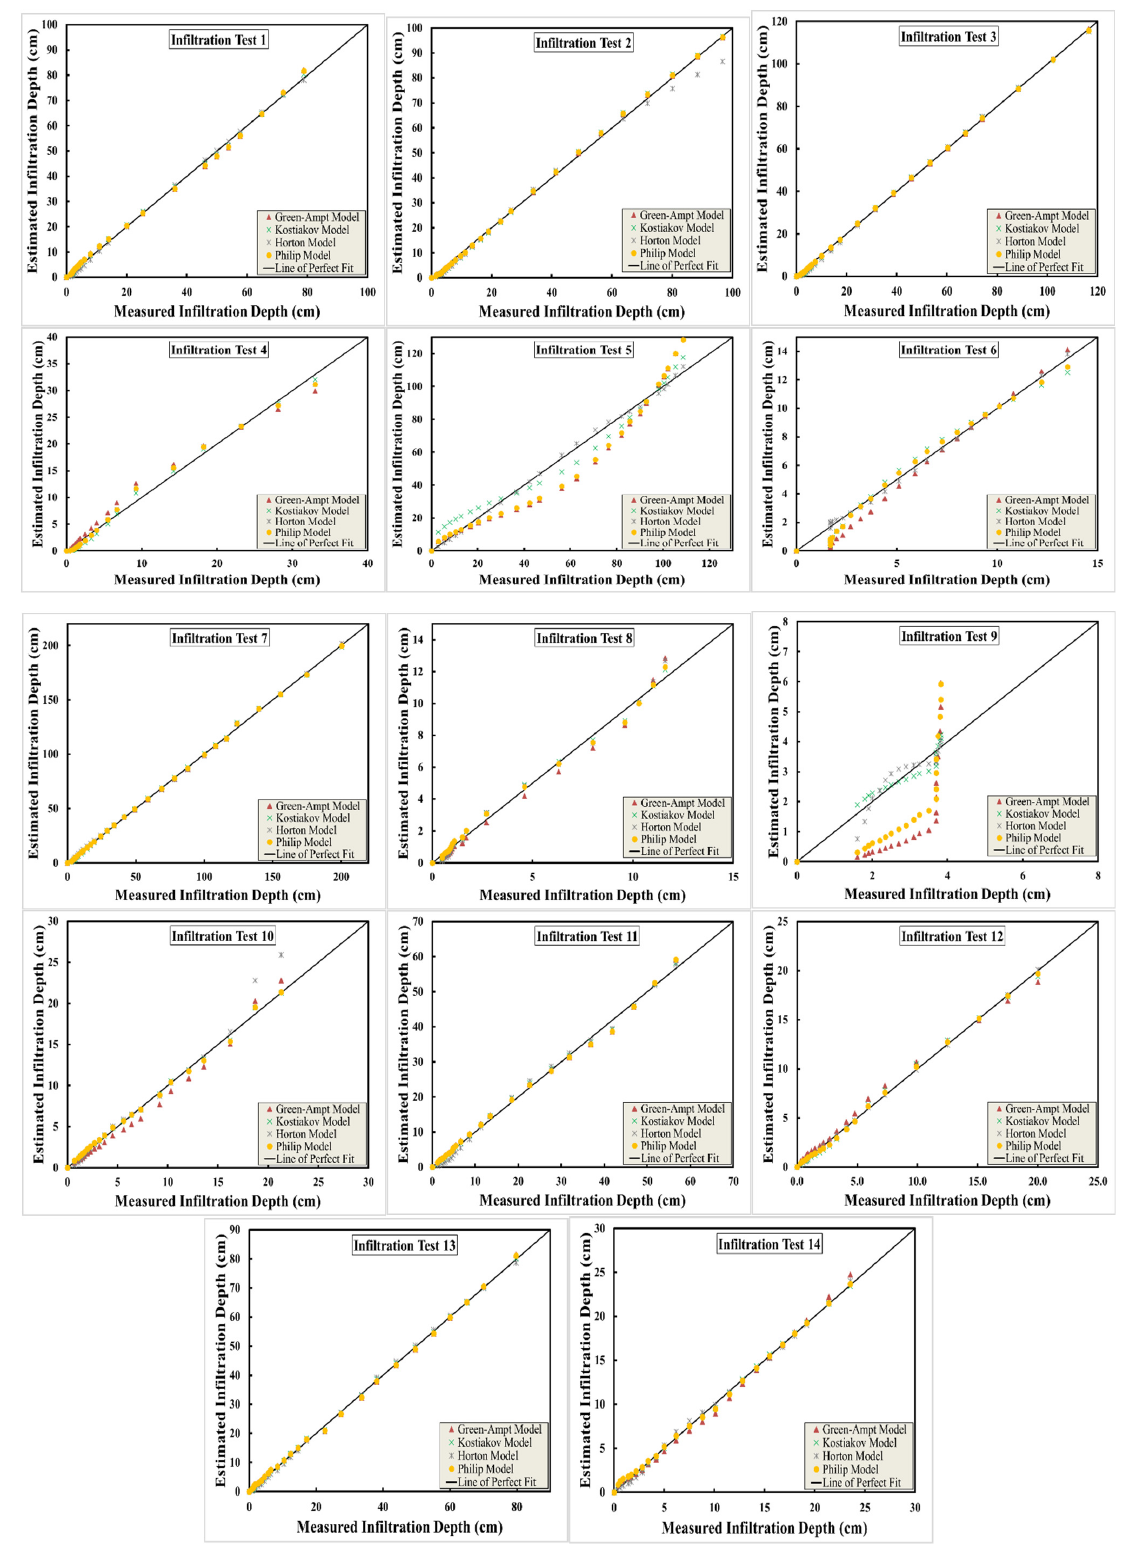
Figure 10. Comparison between cumulative infiltration depth estimated from various infiltration models and measured infiltration rates.